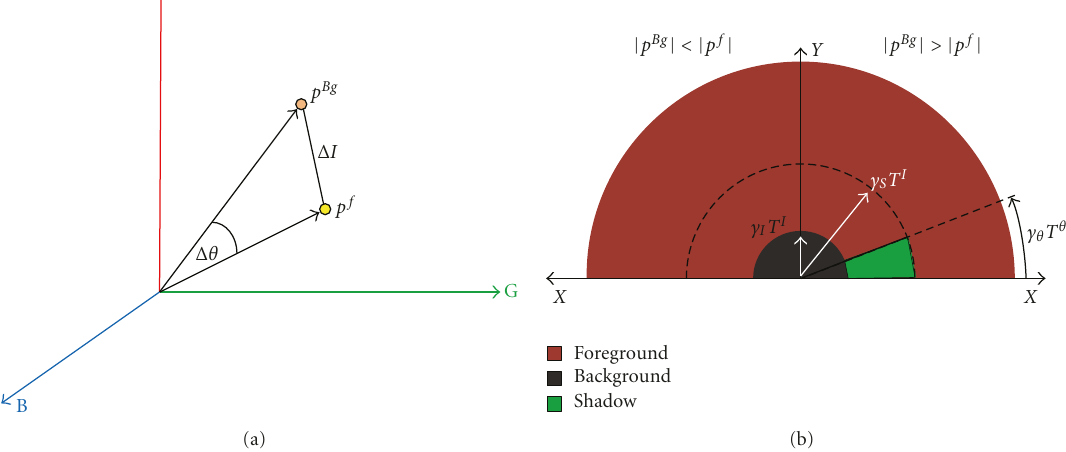
Figure 1: (a) Angle and magnitude di ff erence between two color vector in RGB space. (b) Di ff erence in angle and magnitude in 2D “polar di ff erence space.” The axes are computed as x = Δ I · cos( Δ θ ) and y = Δ I · sin( Δ θ ) .